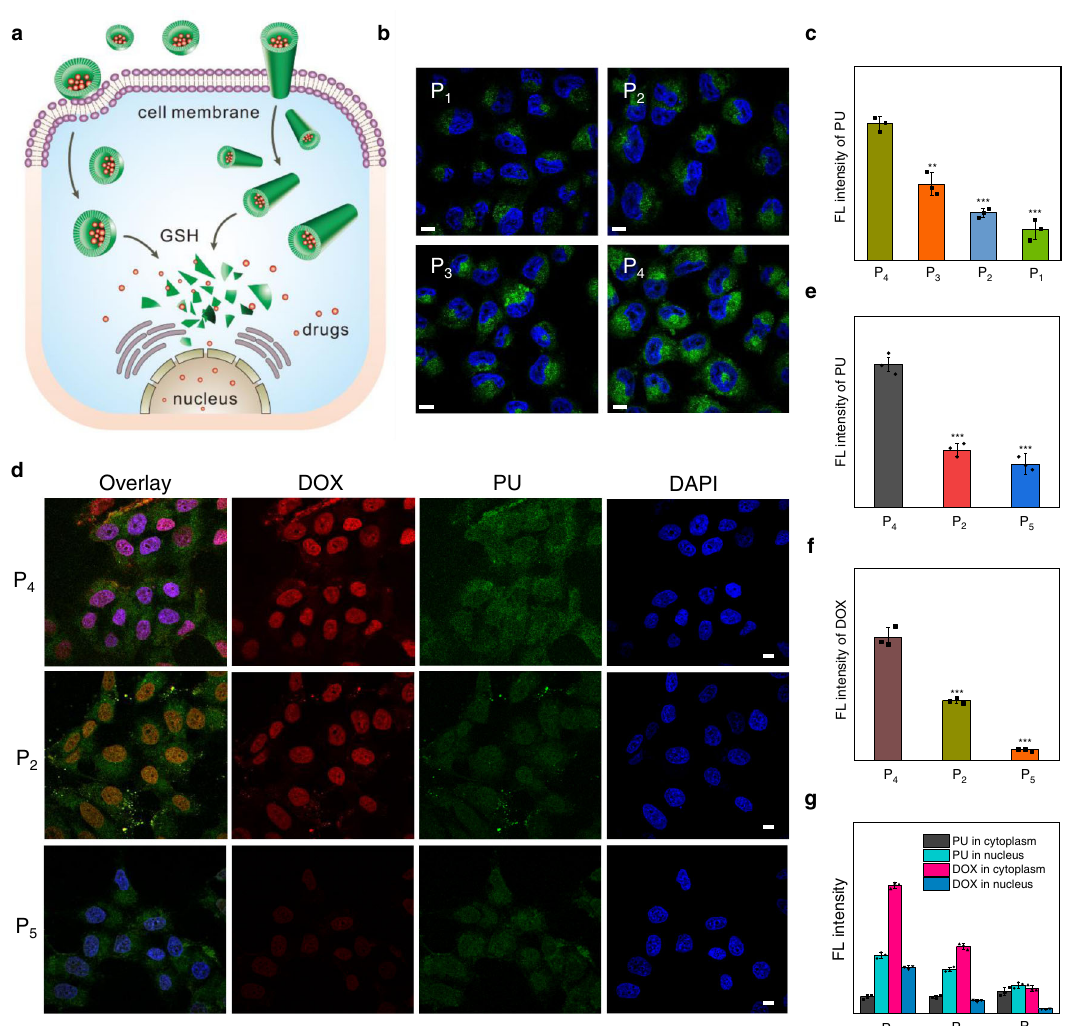
Fig. 5 | Intracellular drug delivery. a Schematic illustration of cellular uptake and intracellular drug delivery properties of PU assemblies with different con- formations and morphologies. b CLSM images of MCF-7 tumor cells incubated with PU assemblies for 2h. Nuclei of cells were stained with 2-(4-amidinophe- nyl)-6-indolecarbamidine dihydrochloride (DAPI, blue). The fl uorescence of PU channel was green, scale bars: 5 μ m. c Fluorescence intensity of PUs in MCF-7 cells after 2h of incubation. Data are presented as mean±SD ( n = 3 indepen- dent cells, left to right: ** p = 0.0084, *** p = 0.0009, *** p = 0.0007). d CLSM